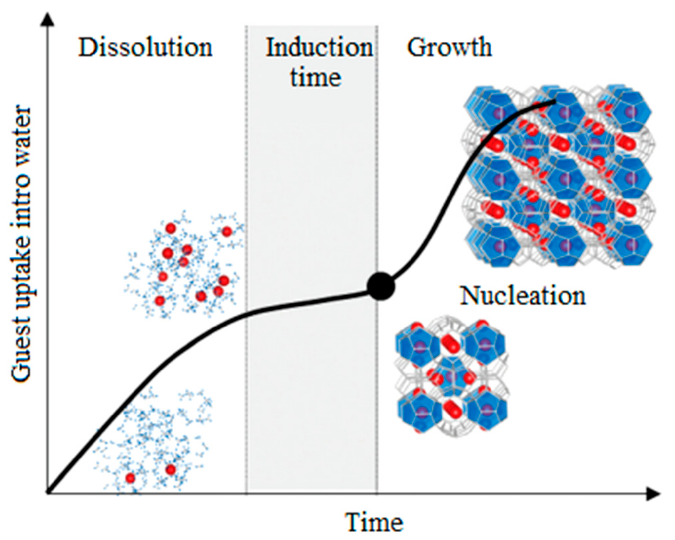
Figure 2. Typical time dependence of the hydrate crystallization process. Reprinted from Ref. [32]. Nucleation and growth of gas hydrate crystals can